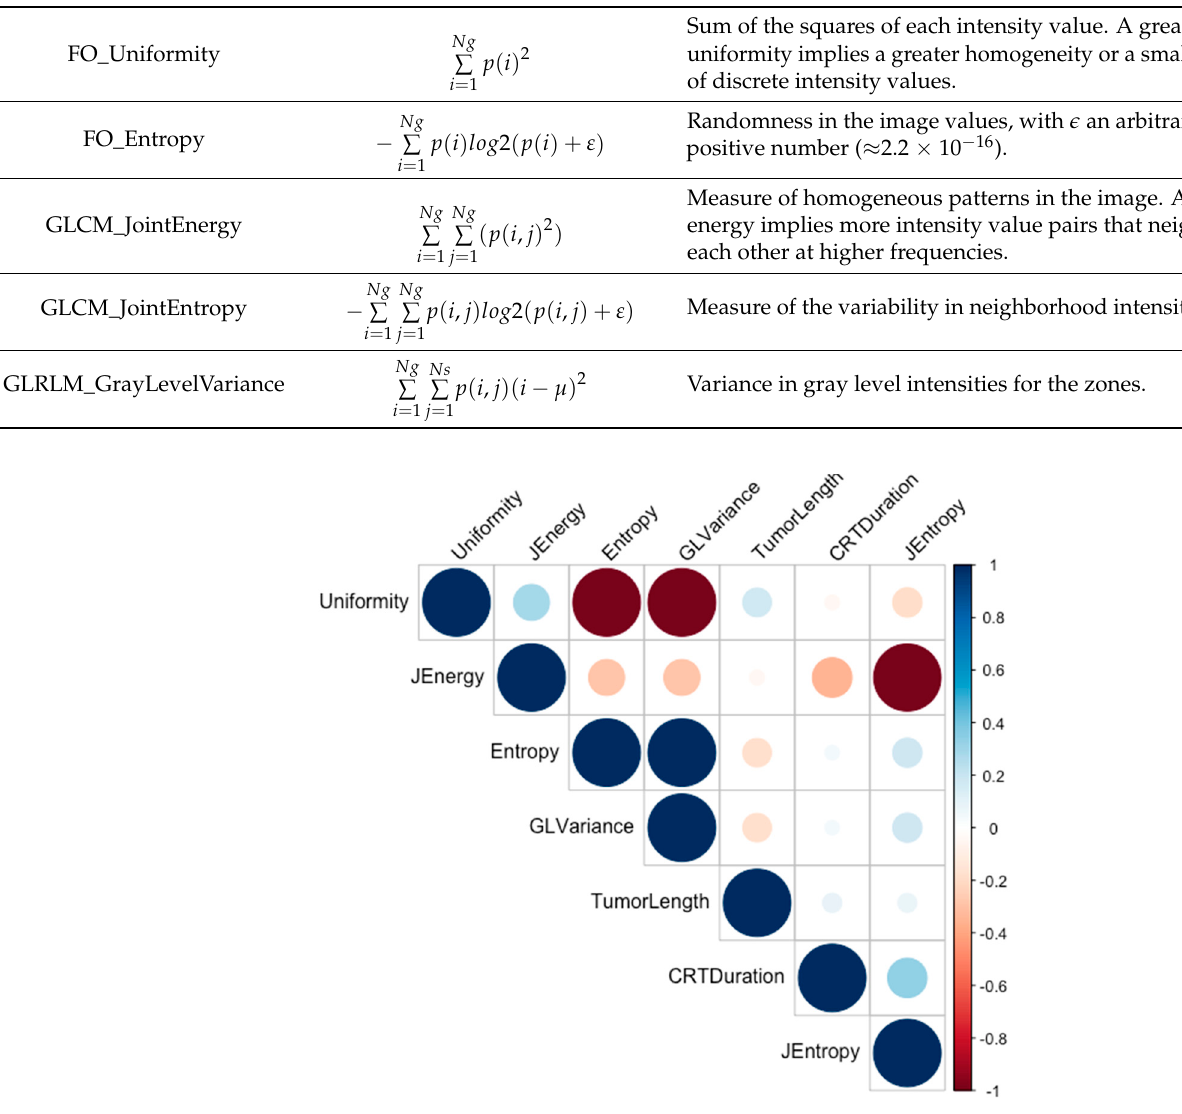
Figure 4. Kaplan–Meier estimates of disease-free survival using the combined (clinical and radiomics) model for ( A ) train- ing and ( B ) testing set, and ROC curve in the testing set ( C ). Table 3. Correlation between variables and 2-year disease recurrence. (Abbreviations: Se = sensitivity, Sp = specificity). Variable Univariate Analysis